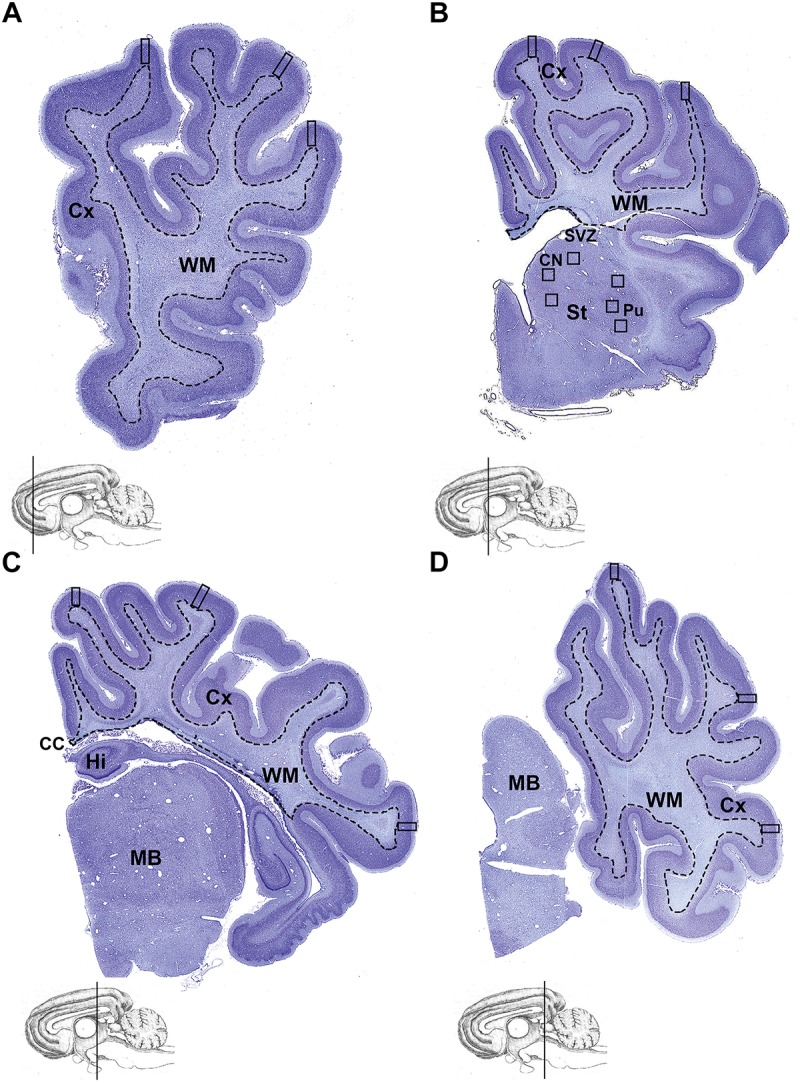
Brain regions analyzed. Coronal, thionin-stained, hemi-sections of the cerebral hemisphere at the level of the (A) frontal, (B) parietal, (C) temporal, and (D) occipital lobe. Cerebral cortex (Cx; regions outside the dashed line) was examined for all histological and immunohistochemical analysis. Measurements were made in the cerebral cortex (squares indicate fields of view; 4 bins analyzed per square for NeuN; 3 bins analyzed per square for Ctip2; whole square without bins analyzed for SST). A total of 6 fields of view was analyzed from the striatum, with 3 fields of view selected from the caudate nucleus and 3 fields from the putamen (B). Cx, cortex; CC, corpus callosum; Hi, hippocampus; St, striatum; SVZ, subventricular zone; CN, caudate nucleus; Pu, putamen; MB, midbrain.